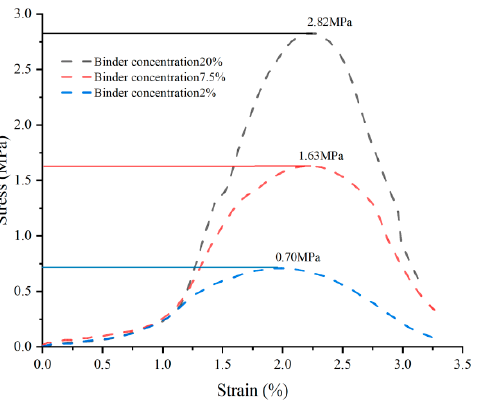
Figure 6. Uniaxial compressive strength of materials prepared with different proportions.